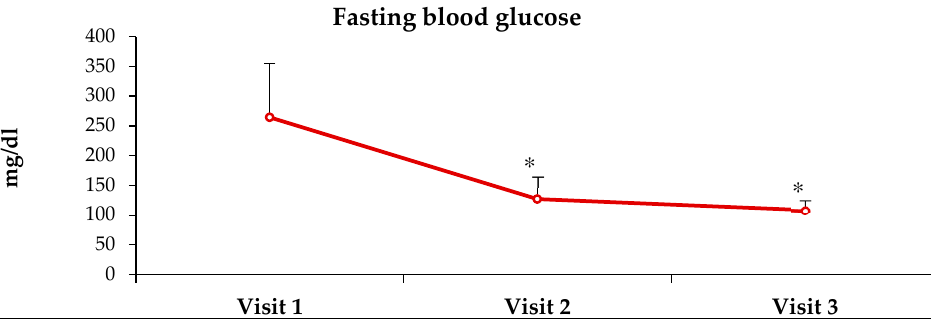
Figure 3. Improvement in glycemic indices after receiving ABCDE. Visit-1 = first visit where ABCDE was provided; Visit-2 and Visit-3 = visits 3- and 6 months after Visit 1. * = p < 0.00001.